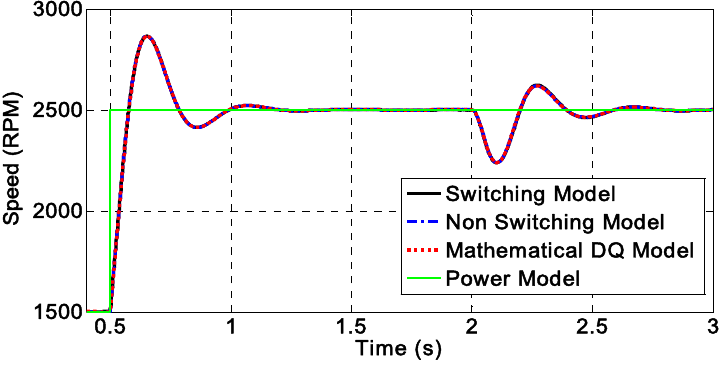
Figure 10. Speed Dynamics for Simulation Detailed in Table